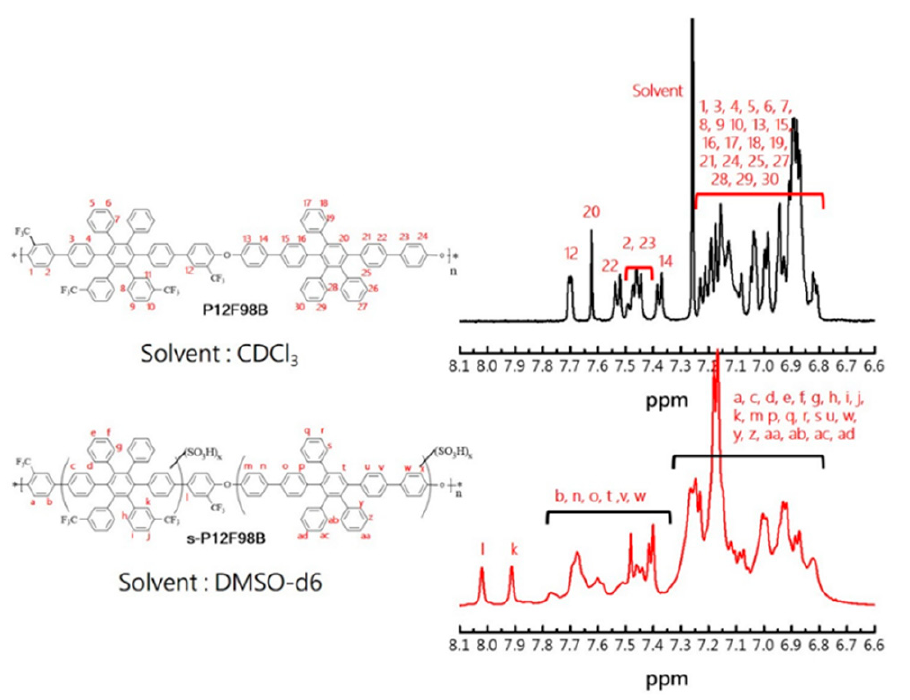
Figure 1. 1H NMR spectrum of P12F99B ( top ) and s-P12F99B ( bottom ) from 6.6 ppm to 8.1 ppm. To confirm the sulfonation of the polymers, FTIR spectroscopy was performed to determine the structural composition of the untreated polymer and polymers with different degrees of sulfonation. After the sulfonation treatment, a broad absorption band was generated from 3749 to 2425 cm − 1 (–OH stretching) and was accompanied by changes in the absorption peaks in fingerprint regions, as shown in Figure S15a,b, which reveals a slight shift of the peak corresponding to symmetrical stretching of C=C absorption from 1492 to 1478 cm − 1 . Larger absorption peaks appear at 1350 and 1010 cm − 1 and correspond to symmetrical stretching and in-plane bending of the O=S=O functional group [40–42]. The appearance of an enlarged shoulder at 1225 cm − 1 is ascribed to asymmetric stretching [43]. The peak corresponding to the absorption of aromatic ethers (Ar–O–Ar) on the main chain remains at 1035 cm − 1